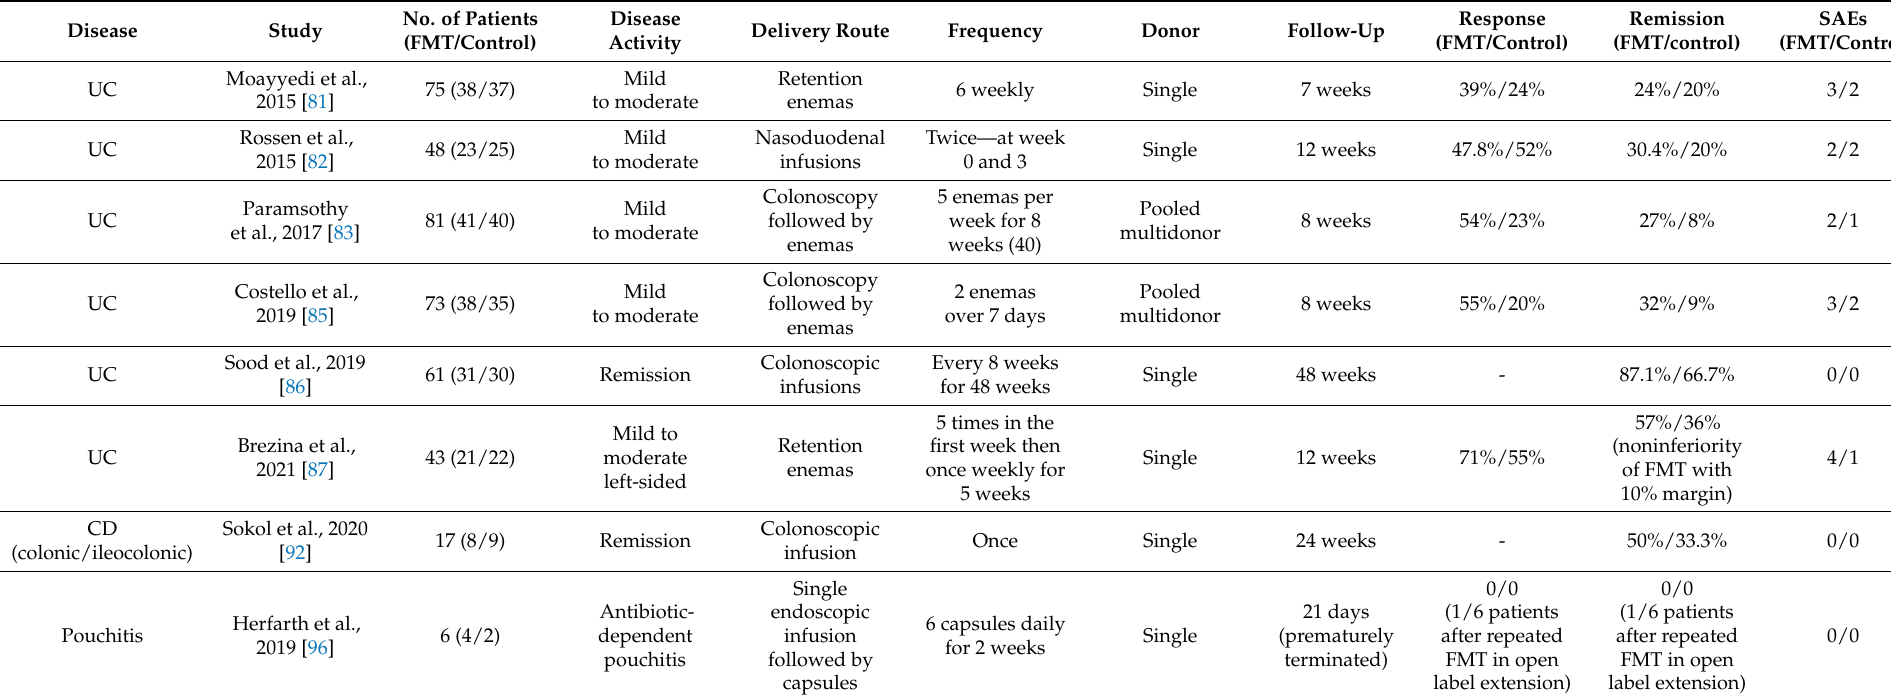
Table 1. Characteristics of published randomized controlled trials on fecal microbiota transplantation (FMT) for inflammatory bowel disease (IBD): ulcerative colitis (UC), Crohn’s disease (CD), and